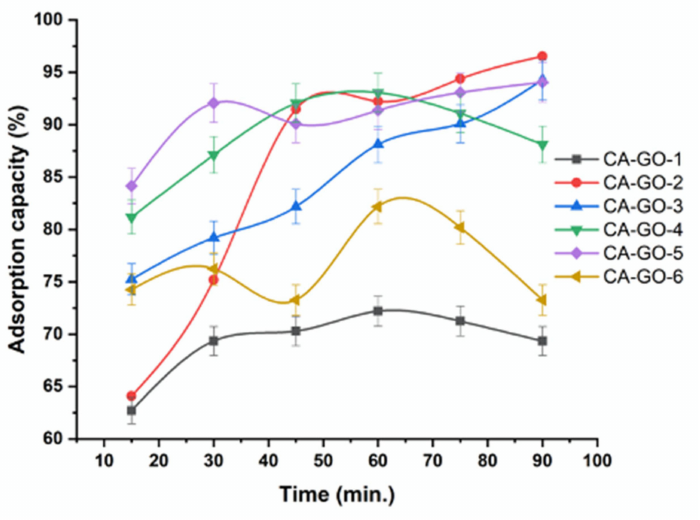
Figure 3. E ff ect of time on the adsorption of Ni 2 + onto